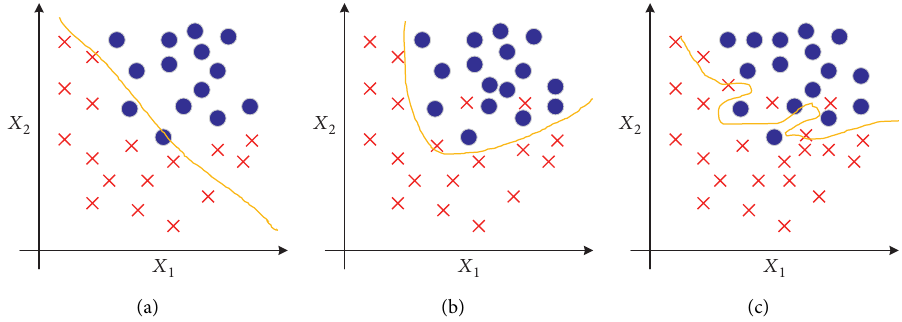
Figure 5: Schematic diagram of overfitting and underfitting: (a) underfitting, (b) balanced, and (c)